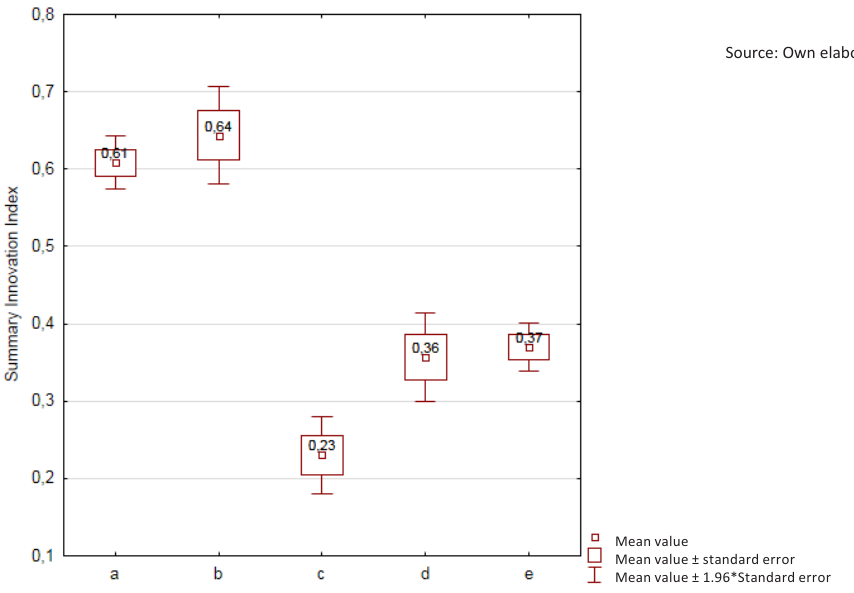
Figure 6. Mean values of the SII in the created